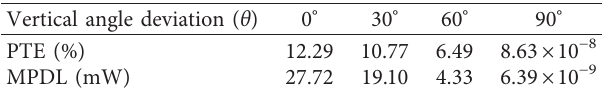
Table 1: Parameters of misaligned coils ( f d 0 � 0mm).